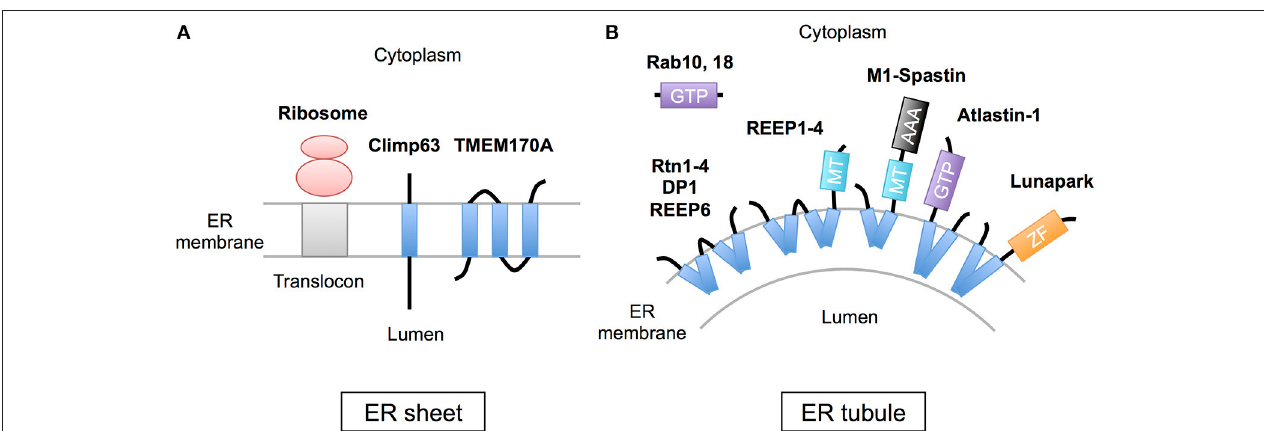
FIGURE 2 | Scheme of the proteins regulating ER morphology. (A) The ER sheet formation is regulated by membrane-attaching ribosomes and two transmembrane proteins, Climp63 and TMEM170A. (B) The ER tubule formation is regulated by a set of hairpin transmembrane domain-containing proteins, including Reticulons (Rtn1-4), DP1 (REEP5), REEP1-4, REEP6, Atlastin-1, M1-Spastin and Lunapark, those generate curvature to bend the membrane. Rab GTPases (10 and 18) are also involved in this process. MT; microtubule binding region, GTP, GTPase domain; ZF, zinc finger